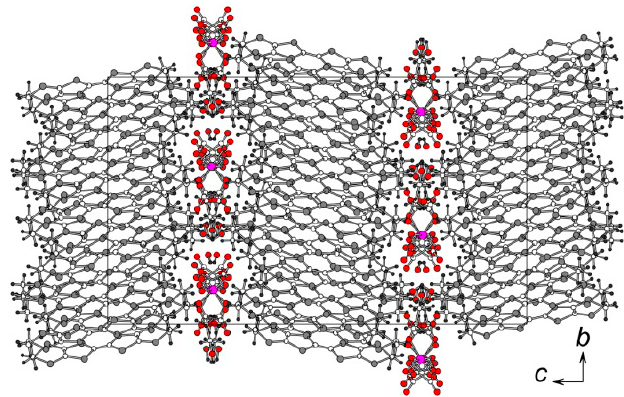
Figure 5. Projection of the structure 5 along a.